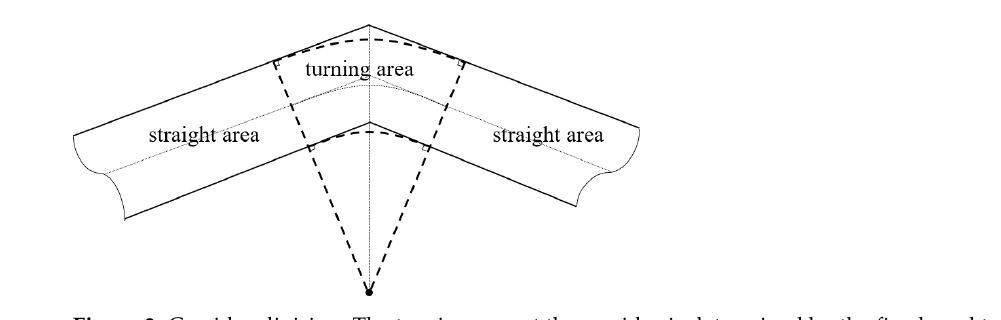
Figure 3. Corridor division. The turning area at the corridor is determined by the fixed road turning center and corridor turning angle.